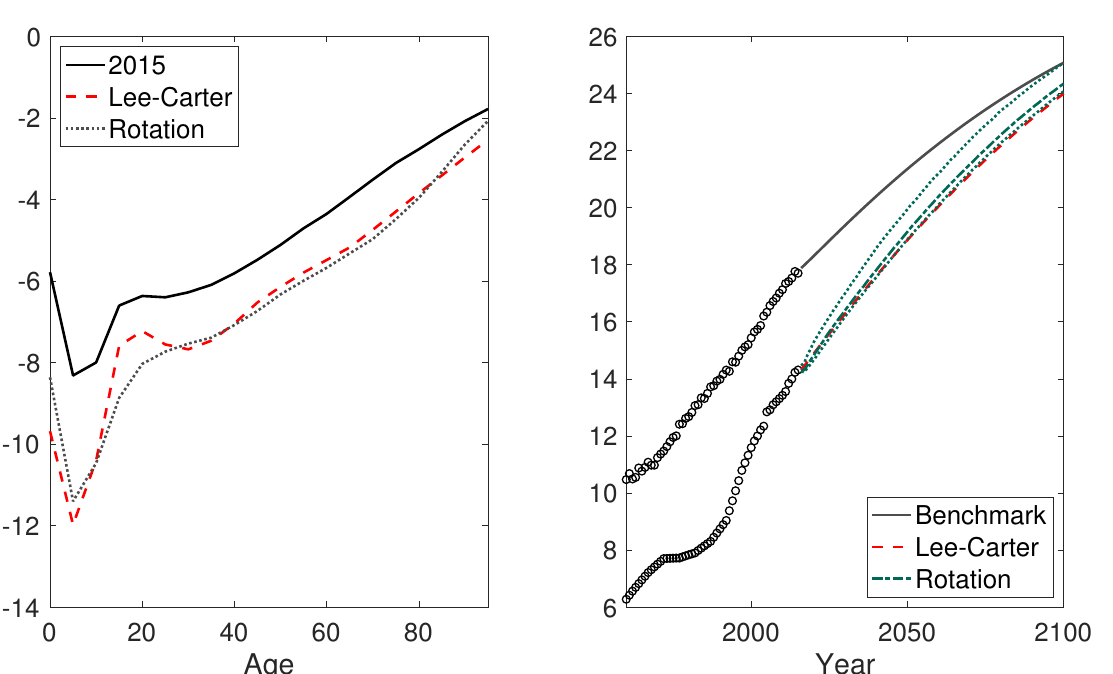
Figure 7. The projected logarithm age-specific death rates ( left panel ) and the remaining life expectancy at 65 ( right panel ) of the average of the benchmark countries and Brazil using different models. For the rotation algorithm, the 2.5%, 50%, and 97.5% quantile of the projected e 65 are plotted.